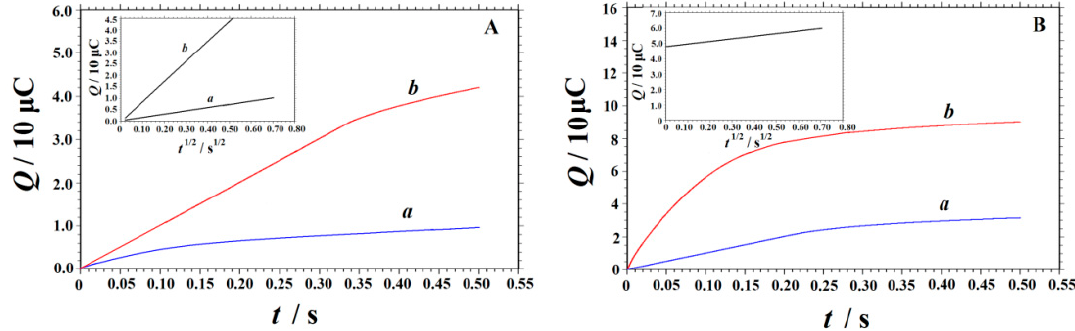
Figure 7. ( A ) Plot of Q–t curves of GCE ( a ) and MnO 2 NRs-ERGO/GCE ( b ) in 1.0 mM K 3 [Fe(CN) 6 ] containing 1.0 M KCl. Insert: Plot of Q–t 1/2 curves on GCE ( a ) and MnO 2 NRs-ERGO/GCE ( b ). ( B ) Plot of Q–t curves of the MnO 2 NRs-ERGO/GCE in 0.3 M citric acid-sodium citrate buffer (pH 4.5) in the absence ( a ) and presence ( b ) of 0.1 mM SY. Insert: Plot of Q–t 1/2 curve on MnO 2 NRs-ERGO/GCE after background subtracted.